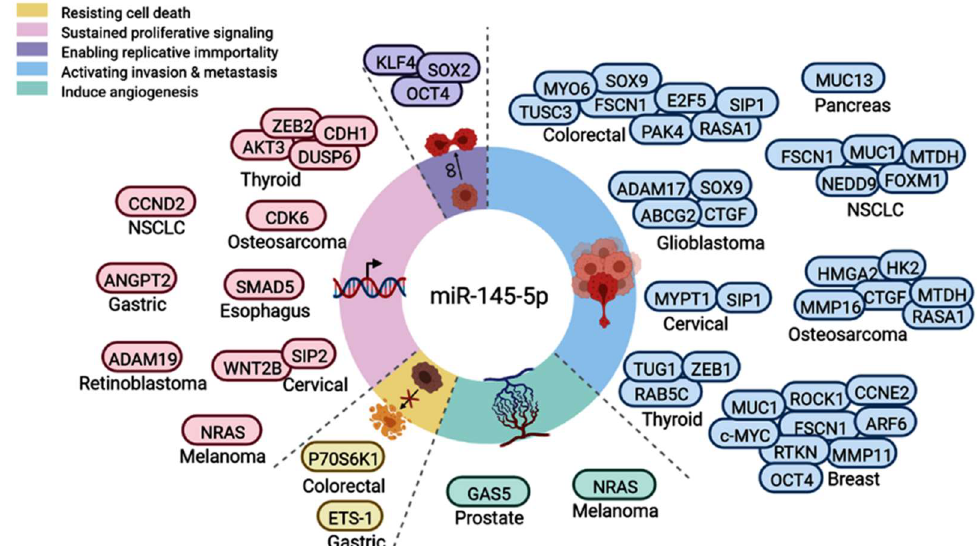
Figure 8. Functional role of miR-145-5p in hallmarks of cancer. Upregulated genes/proteins targeted by miR-145-5p in various types of cancers are shown, leading to resistance to cell death, sustained proliferative signaling, activating invasion and metastasis, or inducing angiogenesis. Pie chart represents the proportion of articles demonstrating these cancer hallmarks.